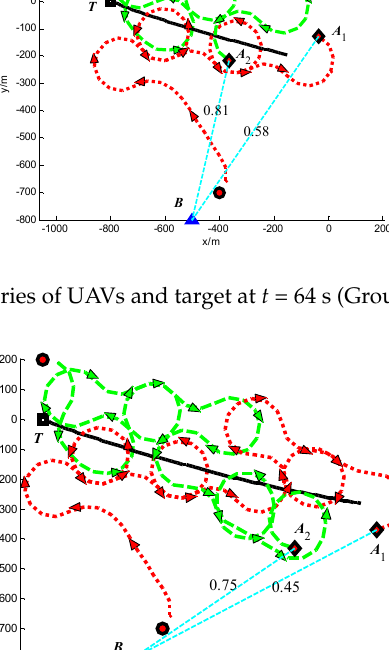
Figure 14. Trajectories of UAVs and target at t = 100 s (Group B in Scenario 1). Appl. Sci. 2018 , 8 , x FOR PEER REVIEW